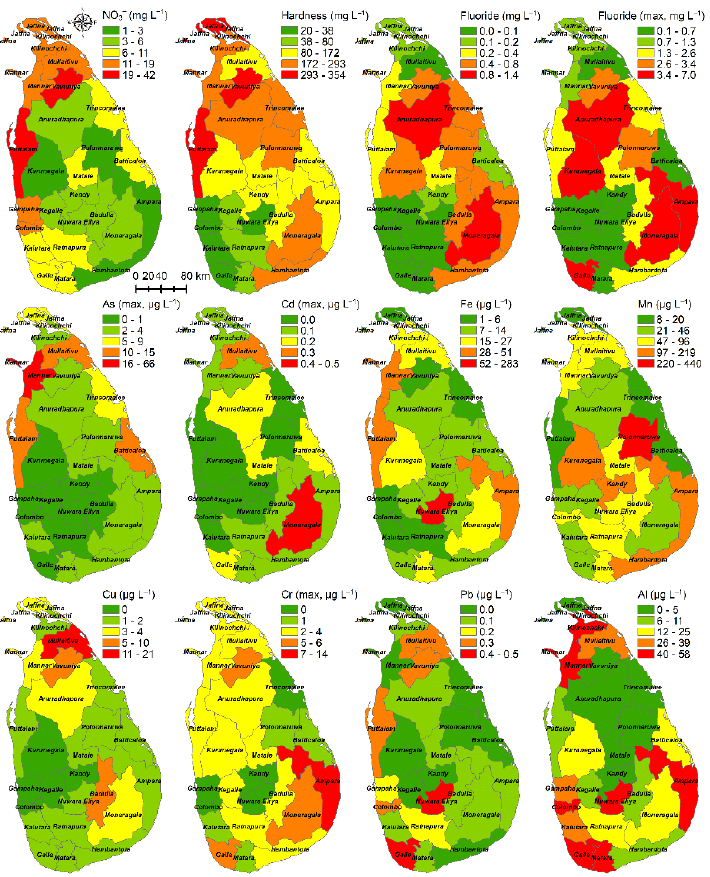
Figure 2. Maps showing the spatial patterns of average concentrations of groundwater quality parameters in each district (maximum concentration (max) was showed for fluoride, As, and Cd). The ranges of data values were categorized into five classes based on the natural break method.